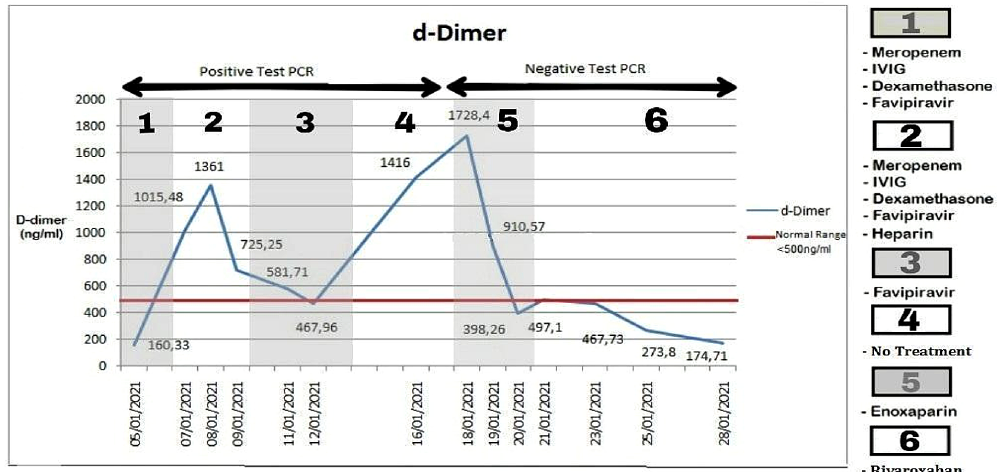
Figure 1. D-dimer levels of the patient over three weeks. Note: bold numbers including those in boxes indicate batches of therapy regimens.